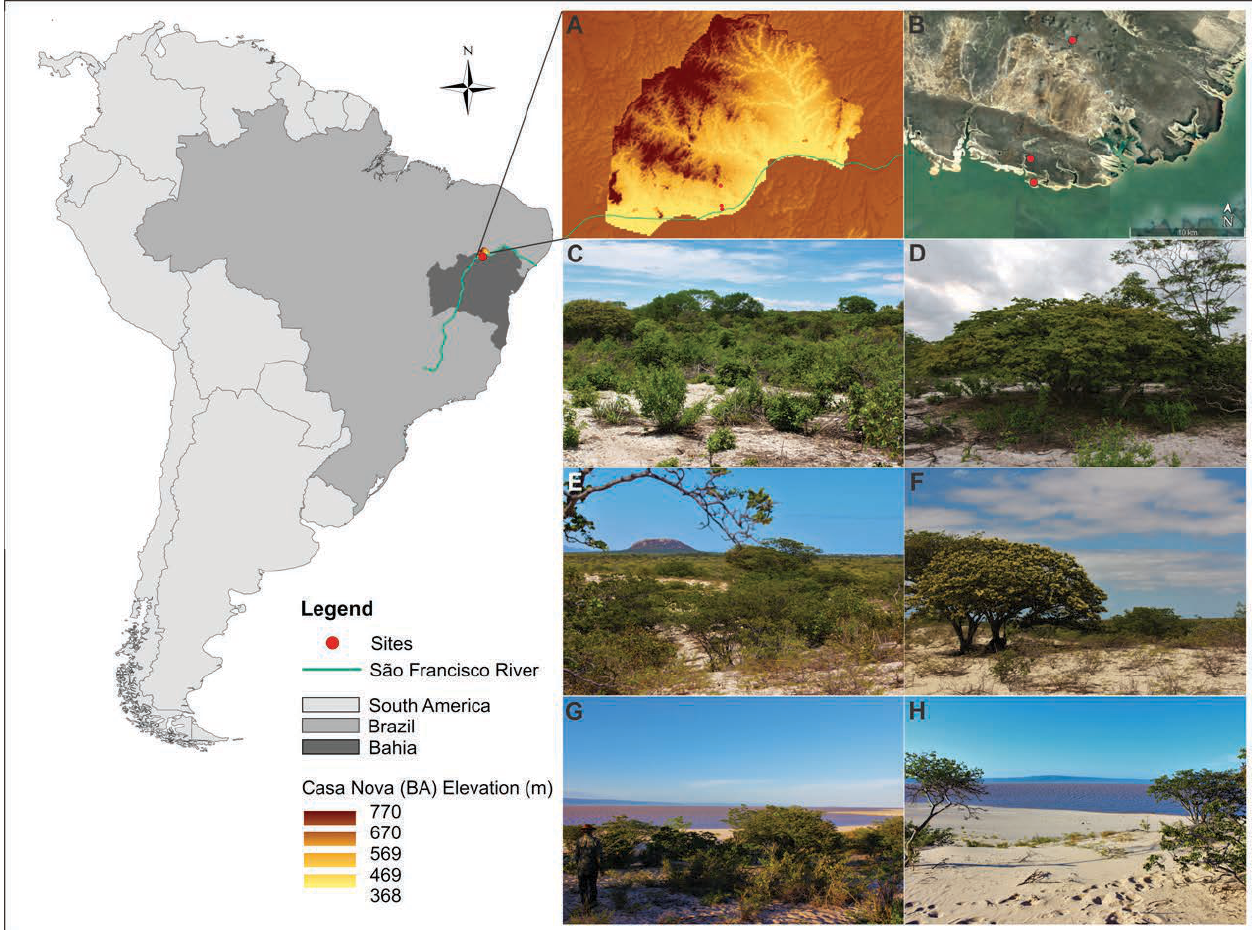
Figure 1 – Location of the Copaifera coriacea population studied, in the municipality of Casa Nova, in northern Bahia State, Brazil. A . Altitudinal variation in the Casa Nova municipality. B . Satellite image showing the study area in detail (source: Google Earth). C–D . First study site. E–F . Second study site. G–H . Third study site. Red dots = localization of the study sites on the maps. Focal individuals in first plane in the photos D, F, and